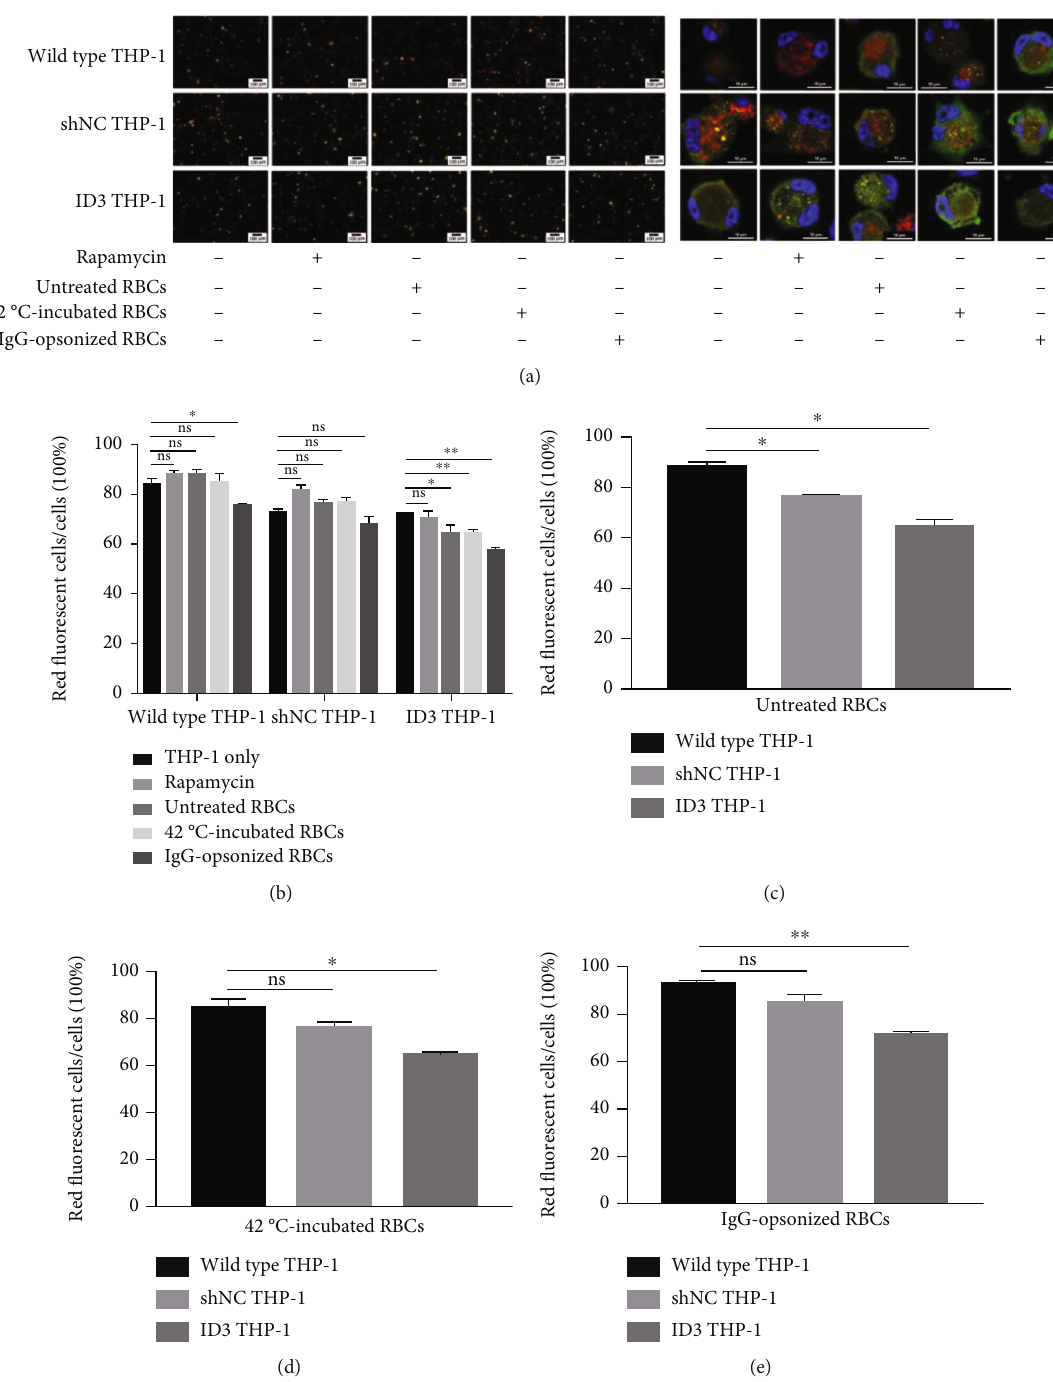
Figure 2: Results of autophagic fl ux in di ff erent THP-1 cells cocultured with three groups of RBCs. (a) Merge photograph of THP-1 cells stably expresses the mRFP-GFP-LC3 fusion protein after di ff erent stimulations. The left column shows the imaging results of the fl uorescence inverted microscope (200 × ), whereas the right column presents the results of the confocal microscope (1,000 × ). The rapamycin group was the autophagy positive control. Each image of the confocal microscope showed one to two THP-1 cells. Compared with wild-type and shNC THP-1 cells, ID3 THP-1 cells demonstrated additional yellow dots when ID3 THP-1 received the same stimulation or engulfed the same treated RBCs. A large number of THP-1 cells can be displayed in the fi eld of the fl uorescence inverted microscope. Additional yellow cells were displayed in ID3 THP-1 cell groups. (b) Histograms of red cell rates of di ff erent RBCs engulfed by three groups of THP-1 cells. (c) – (e) Histograms of red cell rates of three di ff erent THP-1 cells to the same RBCs. ∗ p < 0 : 05 , ∗∗ p < 0 : 01 , ns: not signi fi